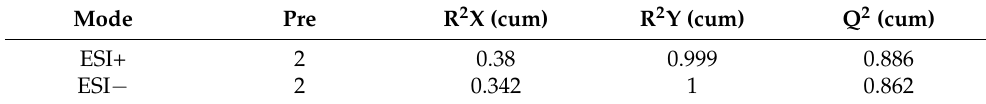
Table 1. Evaluation parameters obtained from OPLS-DA